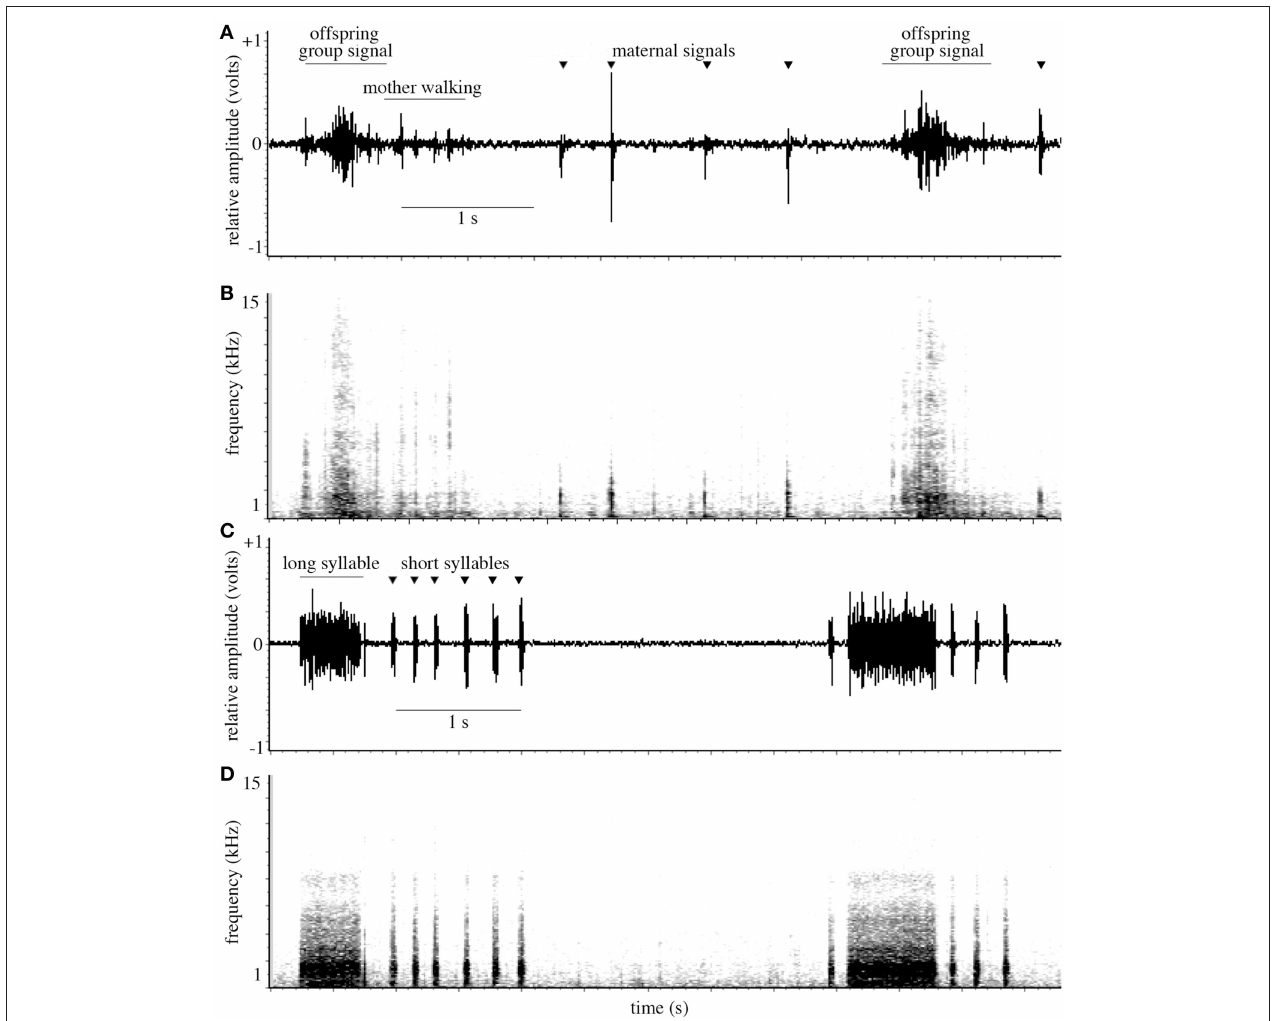
FIGURE 4 | (A) Waveform and (B) spectrogram showing oak treehopper offspring vibrational signals; vibrations from mother walking; and maternal early encounter signals (marked with triangular points). (C) Waveform and (D) spectrogram showing oak treehopper maternal post-search vibrational signals with long and short syllables, produced after a mother has returned to her resting position at the base of the offspring